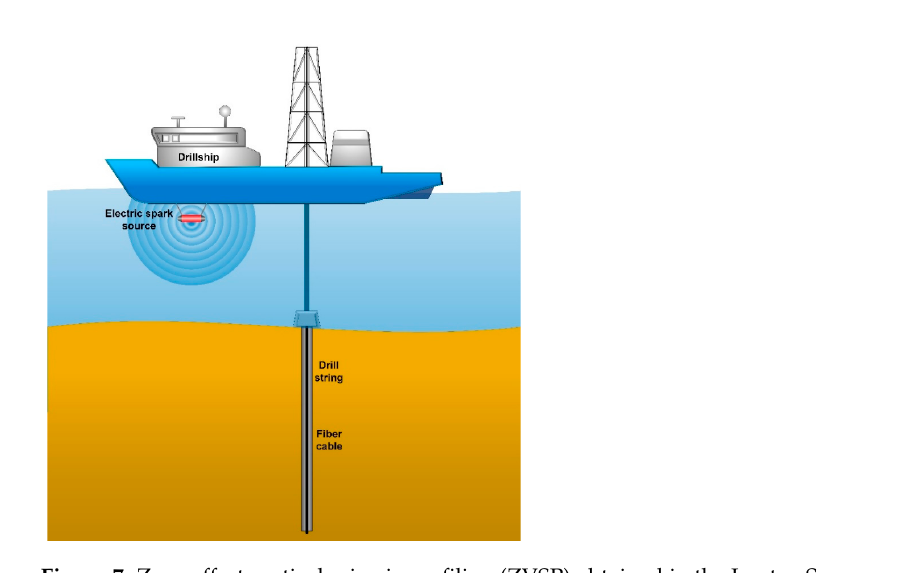
Figure 6. Phase velocity dispersion image of the seismic field record shown in Figure 4. The dark blue color corresponds to the lowest magnitude, the red color corresponds to the highest magnitude. The dispersion image in Figure 6 shows that surface waves with a frequency of about 10 Hz and a phase velocity of about 320 m/s dominate in the resulting record of the seismic field. Further inversion process obtains the velocity profile of the medium [43]. The second experiment with the proposed DAS was a zero-offset vertical seismic profiling (ZVSP) obtained in the Laptev Sea, as shown in Figure 7.